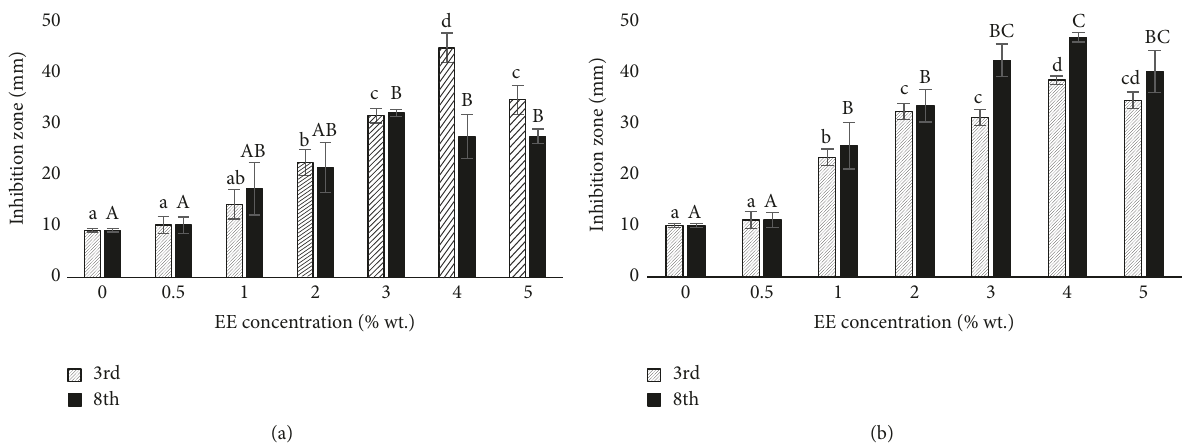
Figure 3: Antimicrobial activity of chitosan films with the oregano EO at days 3 and 8 against Gram-positive bacteria (a) Staphylococcus aureus and (b) Bacillus cereus. The various lowercase and uppercase letters indicate significant differences ( 𝑃 < 0.05 ) between the films on the 3rd and 8th day subsequent to the day they were dried, respectively.